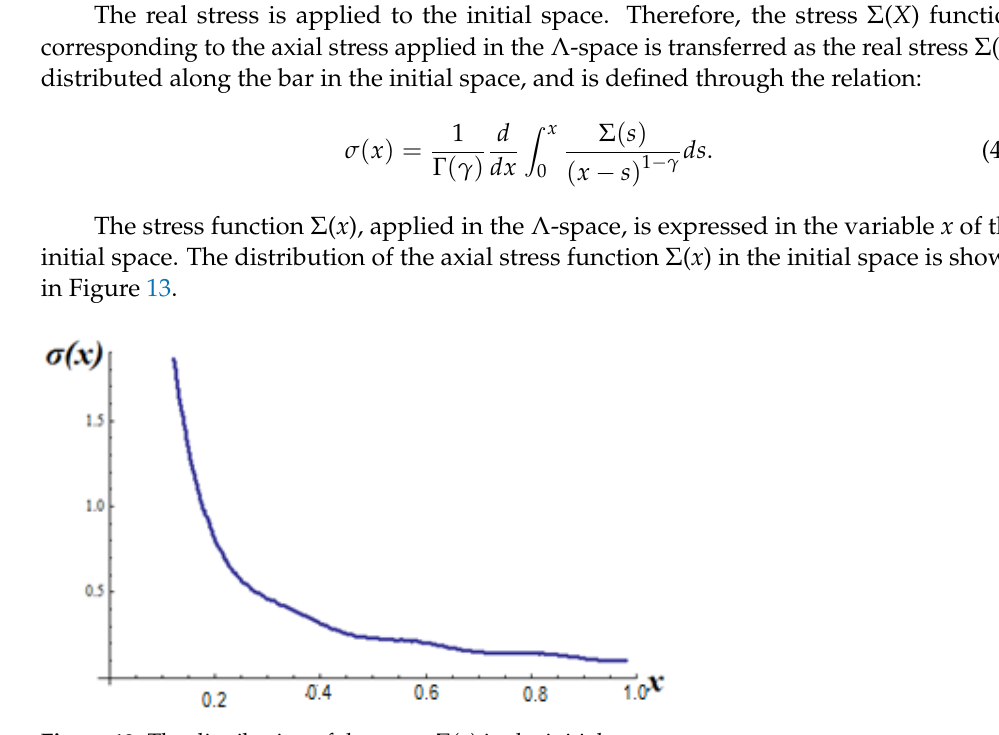
Figure 12. The distribution of the stress Σ ( X ) in the Λ -space.